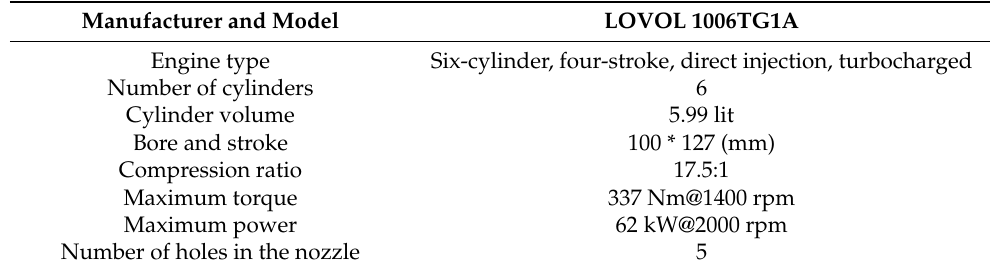
Table 3. Specifications of the test